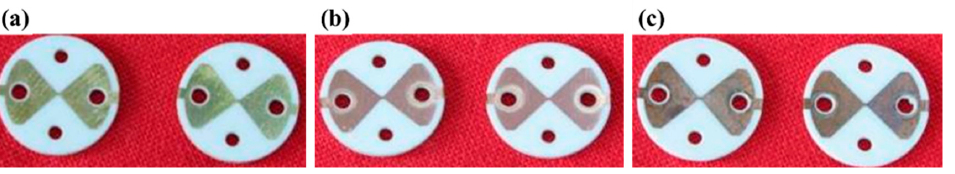
Figure 8. The displacement curves of the flyer velocity for three samples: ( a )1.5 kV and ( b )2.0 kV. It can be seen from Figure 8 that the flyer speed of Sample A is the smallest under the same driving voltage, followed by that of Samples B and C. It can be obtained from the experimental data that, under the same driving voltage, the compactness and the uni- formity of the grain size of the Cu film have a greater influence on the flyer speed. The compactness and grain size of the Cu film are more uniform, and the flyer speed is higher, which is more beneficial for energy conversion. According to the calculation formula of metal resistivity: